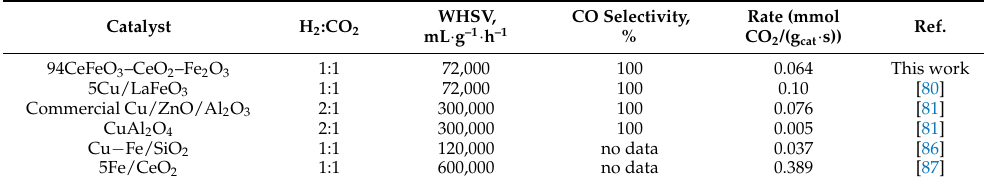
Table 5. Comparison of catalyst selectivity and CO 2 conversion rate, P = 1 atm, T = 600 ◦ C.